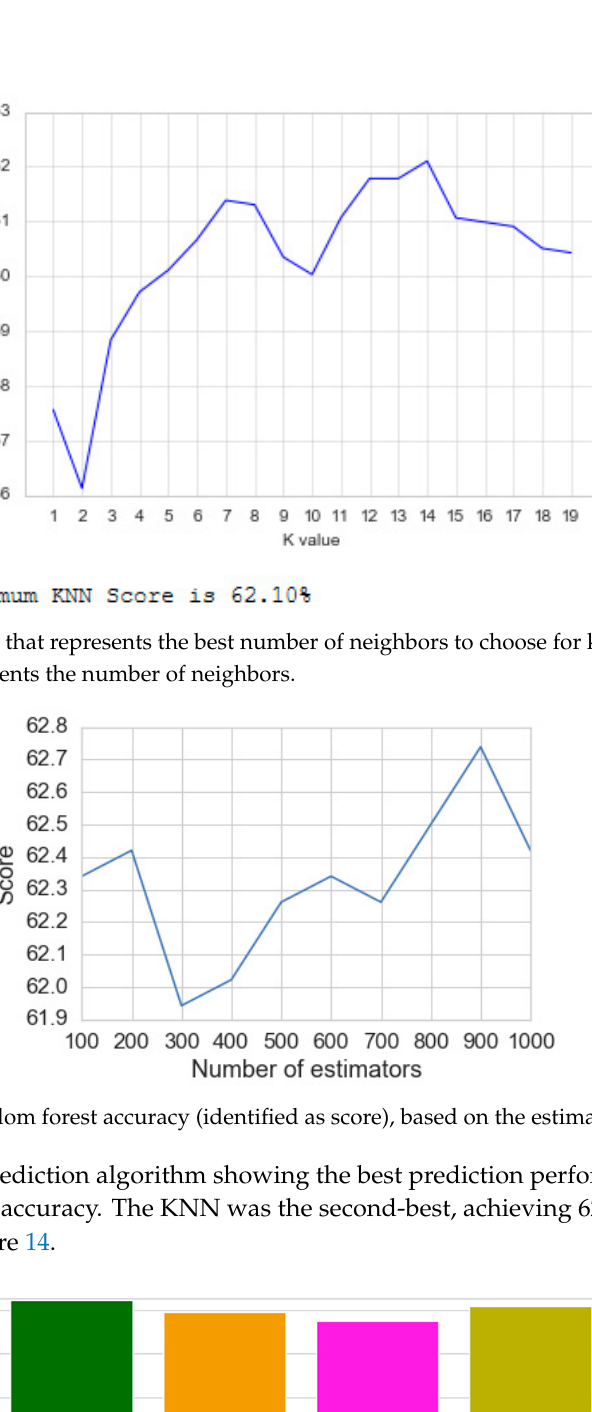
Figure 14. Algorithm accuracy comparison for Dataset 1 with four independent variables with high correlation.